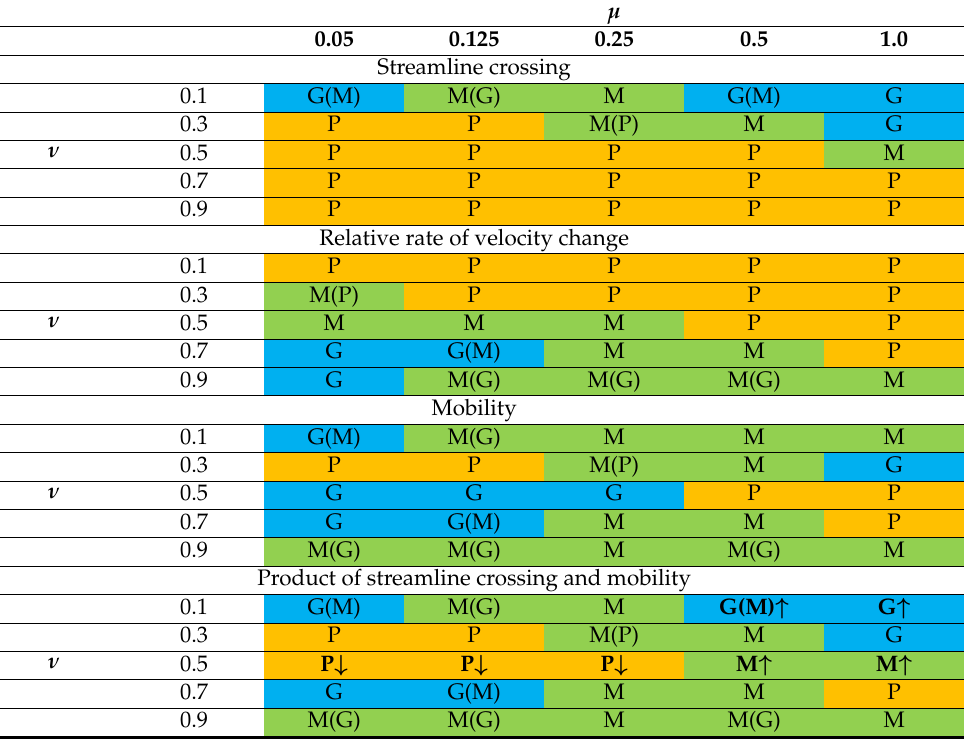
Table 1. Comparisons between Lagrangian and Eulerian results for fixed total time. The agreements are assessed as Poor (P; yellow, overall trend disagreed), Medium (M; green, overall trend agreed), and Good (G; blue, overall trend and the shape of graph agreed). The indicators in parentheses represent the corresponding results for the case of fixed iterations, where this is different to the trend for fixed total